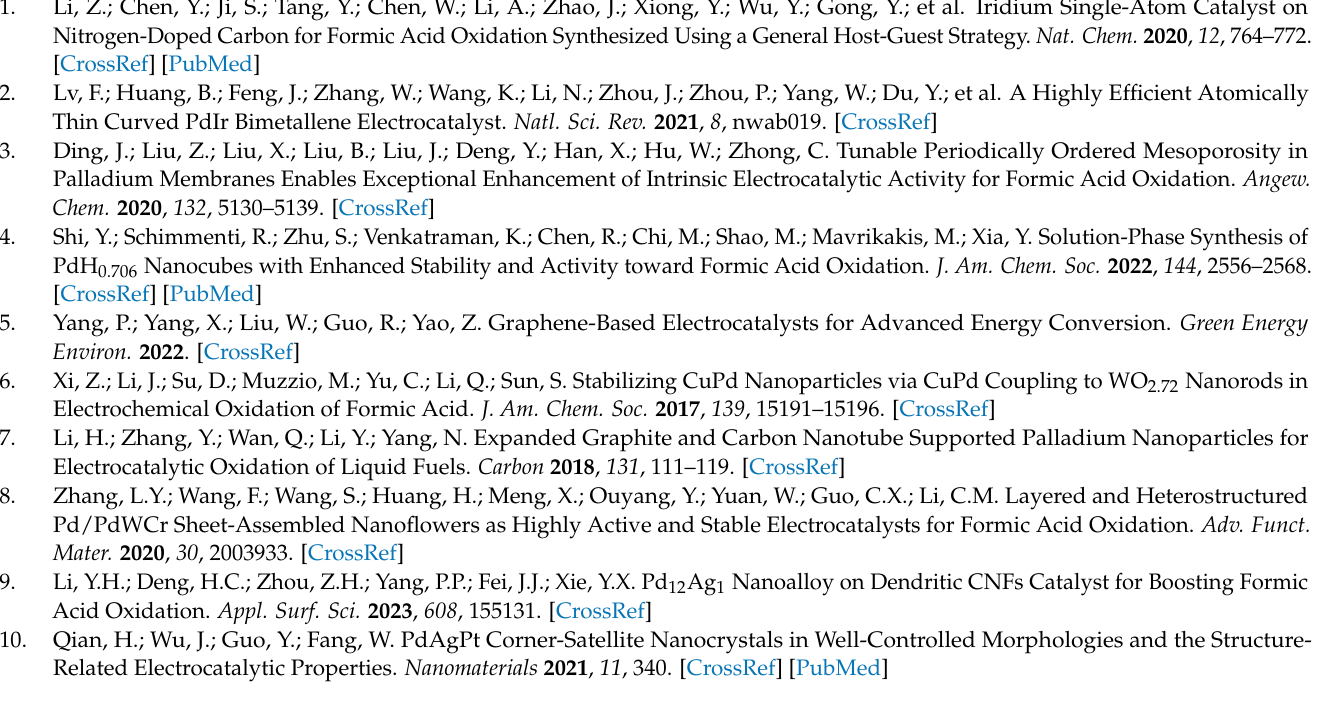
particle size distribution of Pd/CNTs. Figure S9. TEM and HRTEM images of a Pd 3 Co 1 /C catalyst. Figure S10 Cyclic voltammograms curve of Pd 3 Co 1 /C in 0.5 M H 2 SO 4 + 1.0 M HCOOH. Table